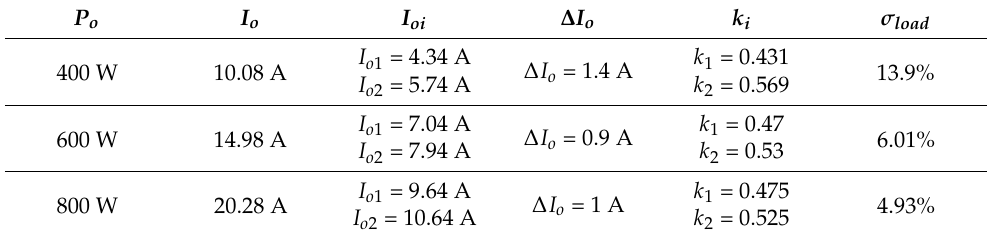
Table 12. Experimental data after only using calculation compensation.